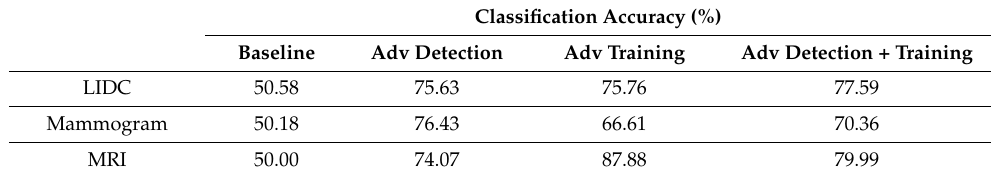
Table 2. Accuracy score (%) of classification DL models after application of adversarial detection, adversarial training, or the combination of adversarial detection and adversarial training. The classification model was evaluated on a combination test set of normal and adversarial images. Adversarial images were generated with BIM with a fixed perturbation size of 0.004. For adversarial detection, the ResNet detector was